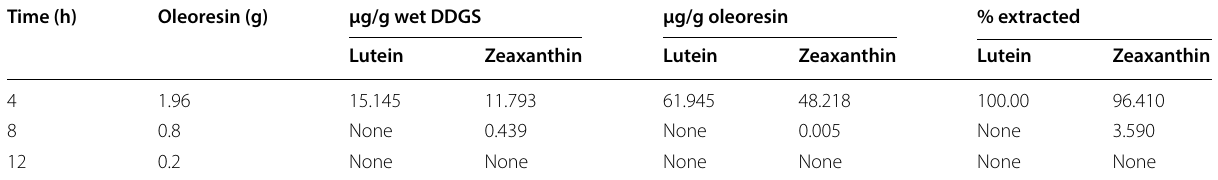
The crude extraction solution was replaced with fresh ethanol every 4 h. The result indicates that four hours is a sufficient time-frame to recover lutein and zeaxanthin from DDGS